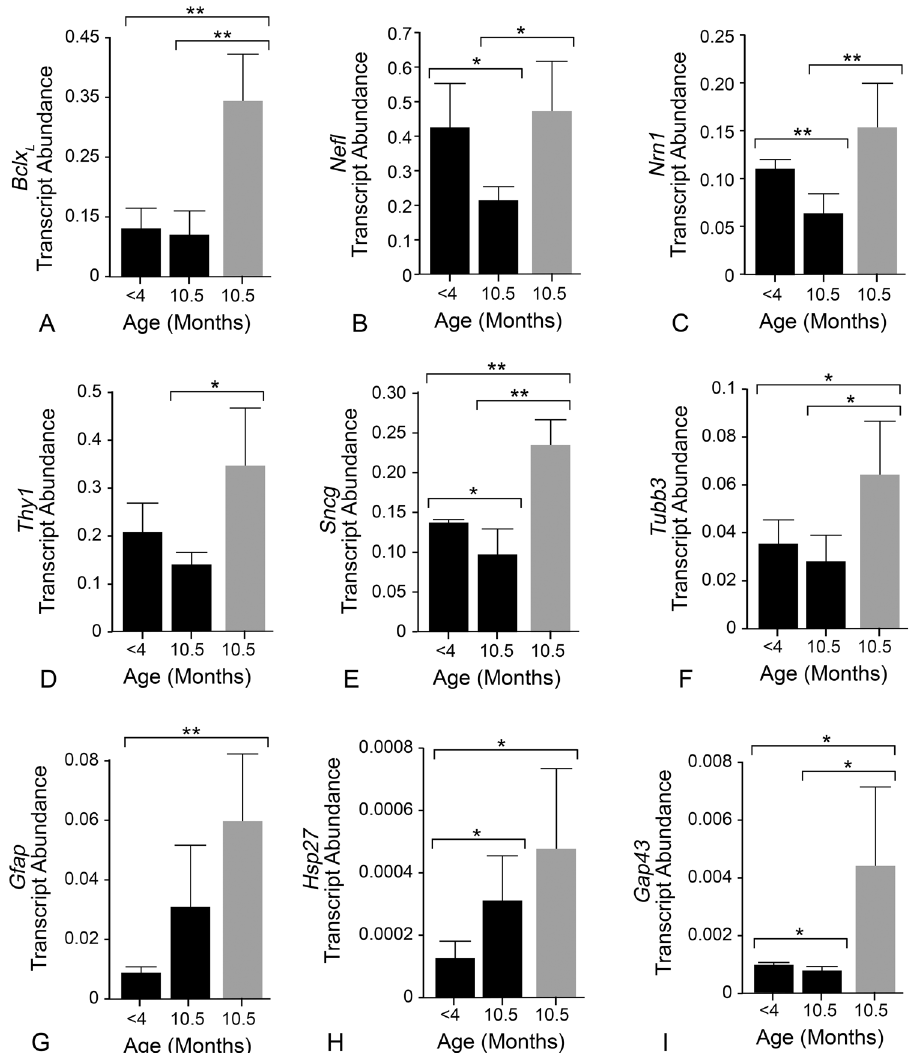
Fig. 6 BCLX L gene therapy attenuates RGC-speci fi c transcript depletion in aged DBA/2J mice. Quantitative (real time) PCR was used to assess retinal gene expression in young mice and glaucomatous mice. A BclX L expression was fi ve times higher in transduced, aged DBA/2J mice (grey bars) than either young or 10.5-month-old naive animals (black bars). B – F The transcript abundances of fi ve RGC-speci fi c/selective transcripts. RGC transcripts were consistently more abundant in aged mice that were BCLX L treated than age-matched mice that did not receive BCLX L . G , H The transcript abundance of Gfap and Hsp27 , two transcripts produced in retinas experiencing glaucomatous stress. These transcripts were signi fi cantly more abundant in aged mice relative to the young mice that had not developed glaucoma. I The transcript abundance of Gap43 , a gene that has been associated with neuroregeneration. Gap43 was more abundant in BCLX L -treated, 10.5-month-old mice than young or 10.5-month-old naive mice. Four groups of three pooled eyes were used for each experimental cohort. The graphs display the average abundance of the four groups and the error bars show the standard deviation from that average. All transcript levels are quanti fi ed as the number of target molecules present per molecule of S16 ribosomal protein mRNA. Statistical evaluation was made using unpaired t tests of the means (* P < 0.05, ** P <